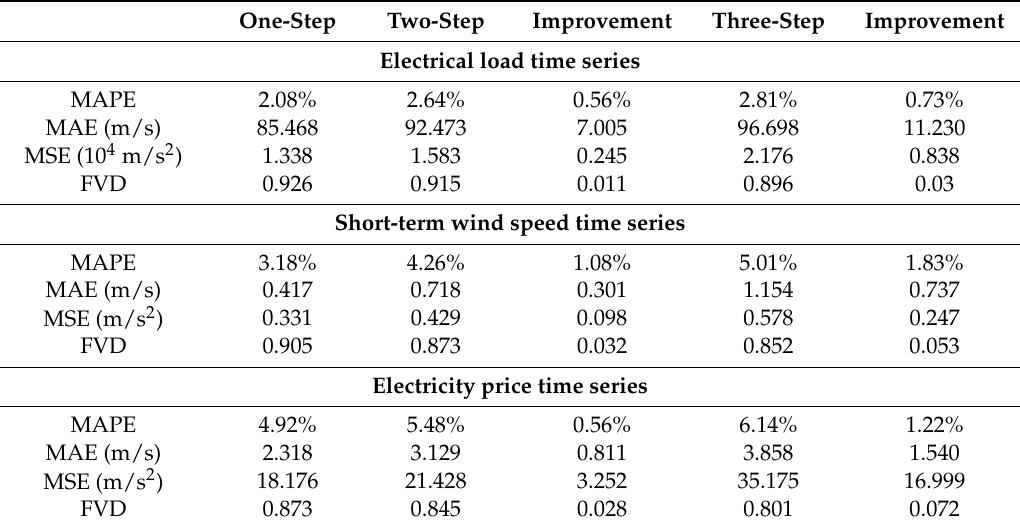
Table 8. Comparison of multi-step forecasting accuracy.